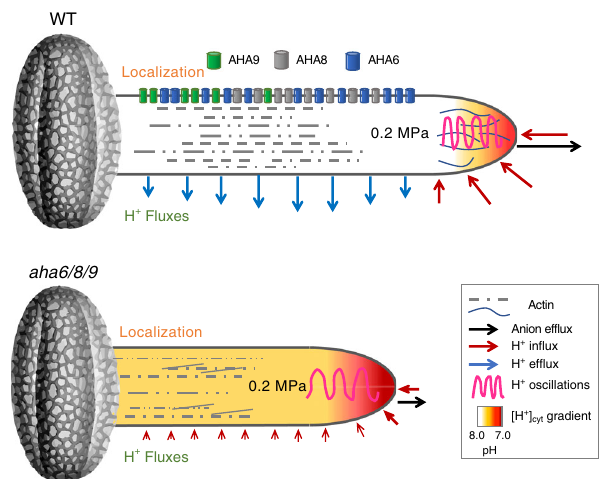
Fig. 6 Model implicating plasma membrane H + -ATPases (AHAs) in the spatio-temporal control of ion fl uxes and intracellular gradients required for actin organization during pollen tube growth. In the absence of AHAs (barrel shapes), extracellular H + fl uxes (colored arrows) and anionic ef fl ux (black arrow) vanish, leading to a lower pH throughout the tube with a shallower cytosolic pH gradient (color fi ll heatmap), lower frequency of synchronized growth rate/[H + ] cyt oscillations (magenta trace), and absence of organized actin at the tip (thin black lines), ultimately resulting in growth defects (represented by a shorter tube). Modi fi ed image of an Arabidopsis pollen grain by courtesy of Prof. David Twell,